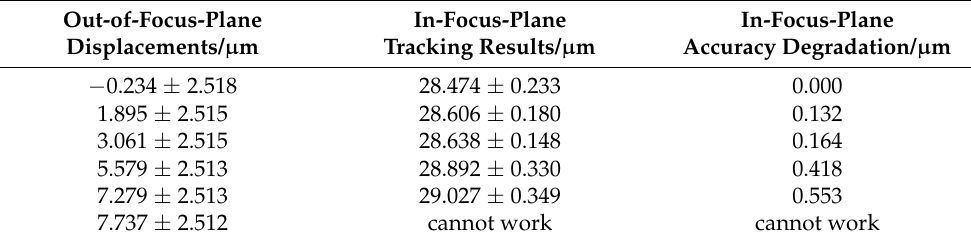
Table 1. In-focus-plane tracking results excited by out-of-focus-plane displacements.